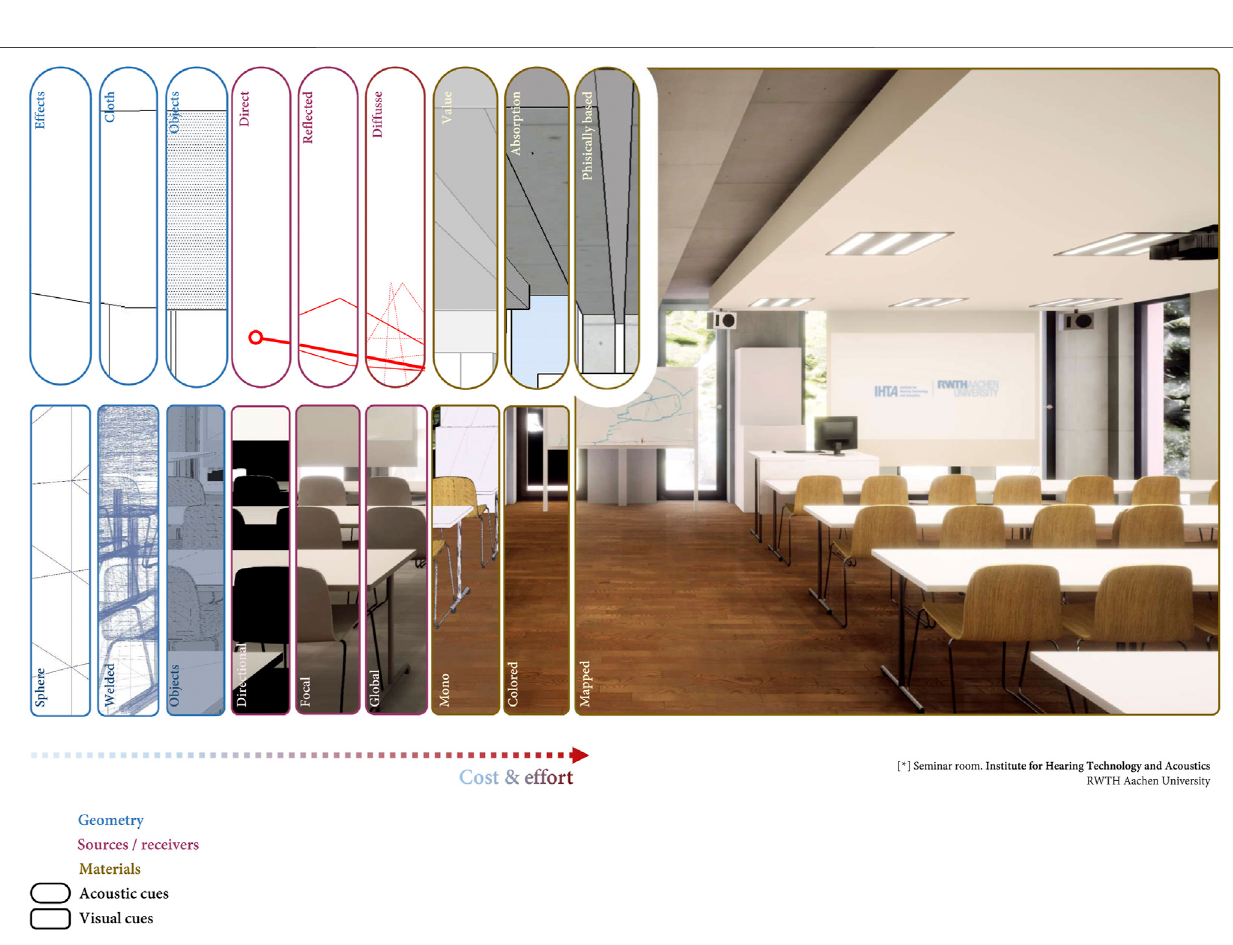
Frontiers in Built Environment |